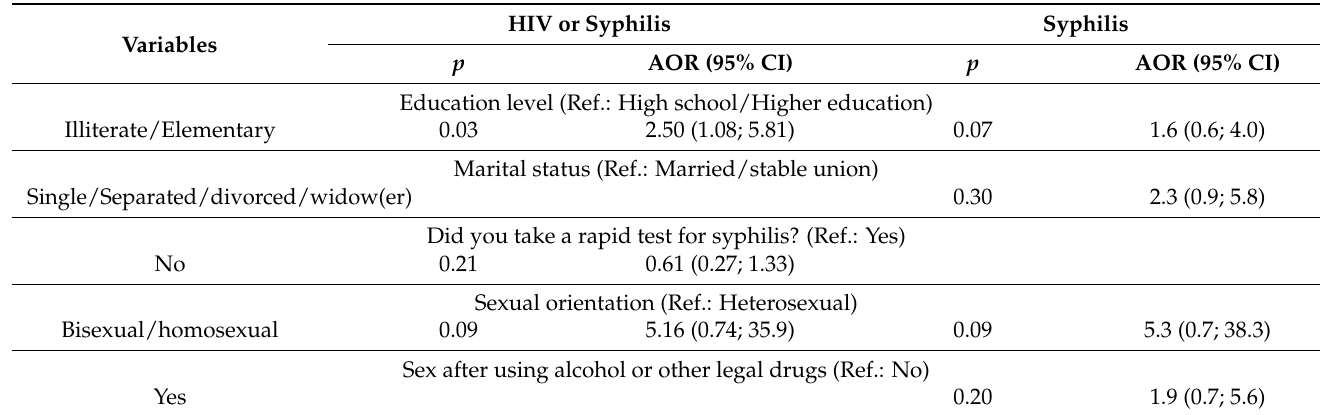
Table 4. Results of the multiple logistic regression analysis between factors Sexually Transmitted Infections among elderly in a subnormal agglomeration in the Brazilian Amazon.